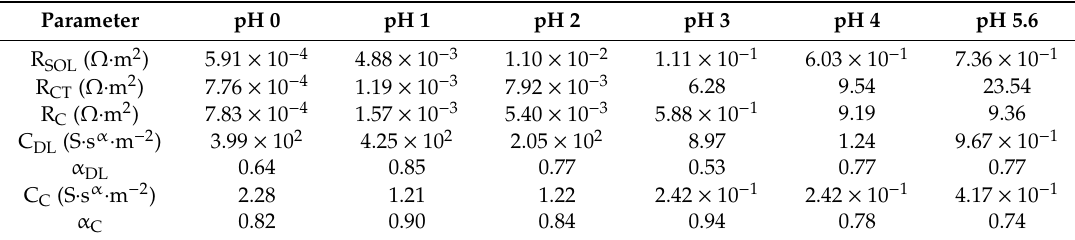
Table 6. Results of EIS spectra fitting (RSOL—resistance of the solution; RC—resistance of the passive layer; RCT—charge transfer resistance; CDL—capacitance of electrical double layer; CC—capacitance of passive layer).